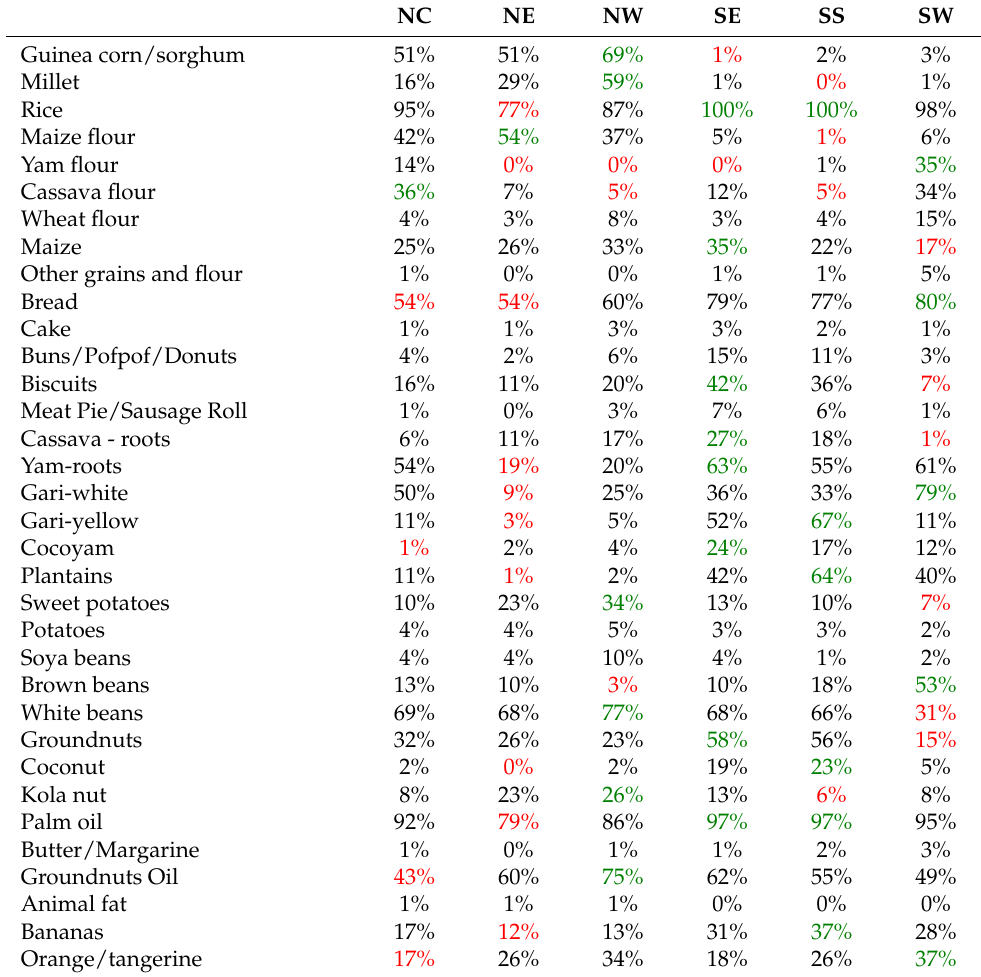
Table A6. Foods consumed in the 7 days prior to the survey by Nigerian households in different zones